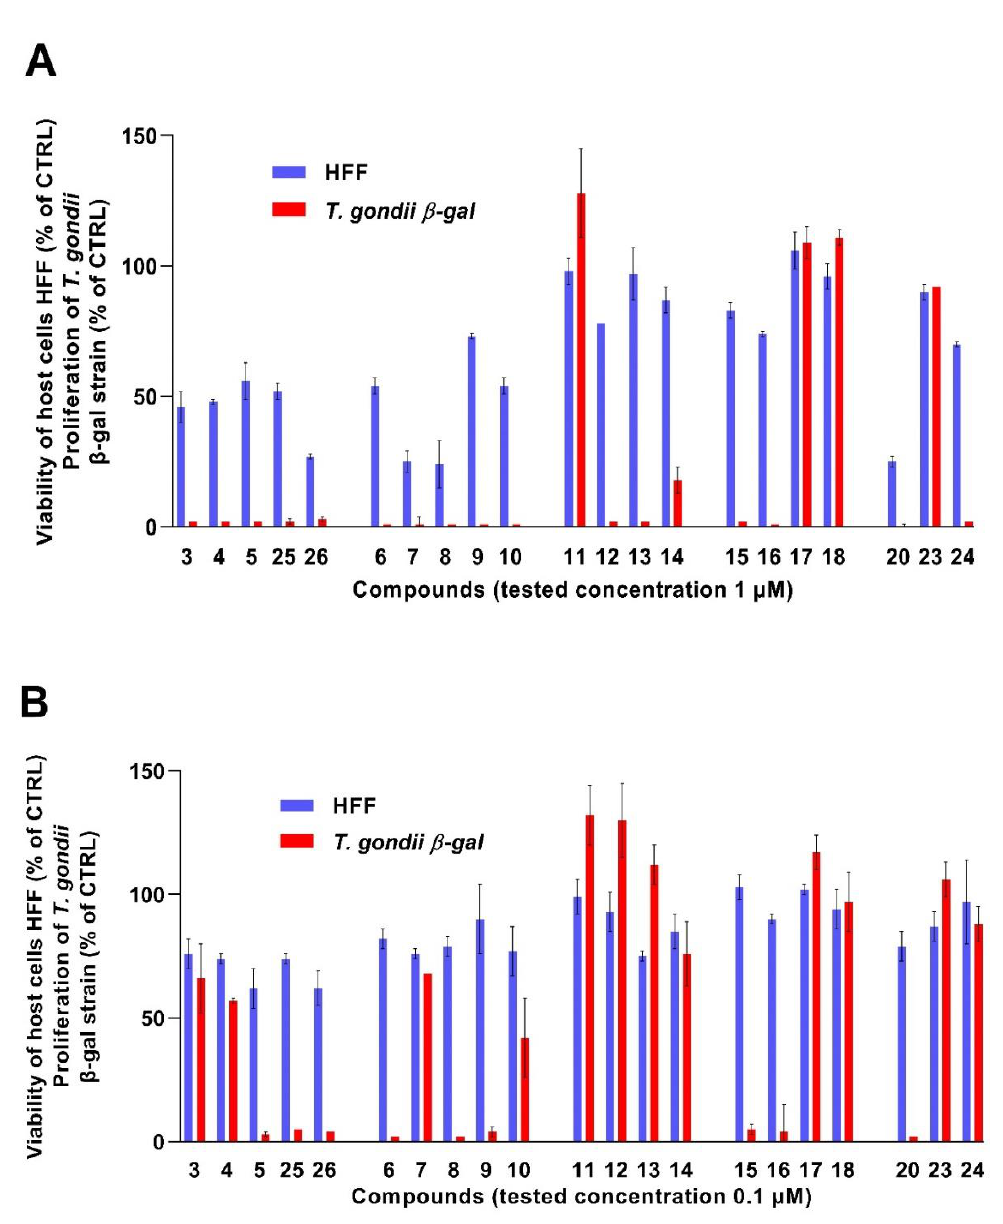
Figure 4. Clustered column chart showing the in vitro activities at 1 ( A ) and 0.1 ( B ) µ M of the 21 compounds on HFF viability and T. gondii β -gal proliferation. Non-infected HFF monolayers treated only with 0.1% DMSO exhibited 100% viability and 100% proliferation was attributed to T. gondii β -gal tachyzoites treated with 0.1% DMSO only. For each assay, standard deviations were calculated from triplicates. Data for compounds 3 , 4 and 5 were previously reported [66] and data for 25 and 26 are part of another study [104].